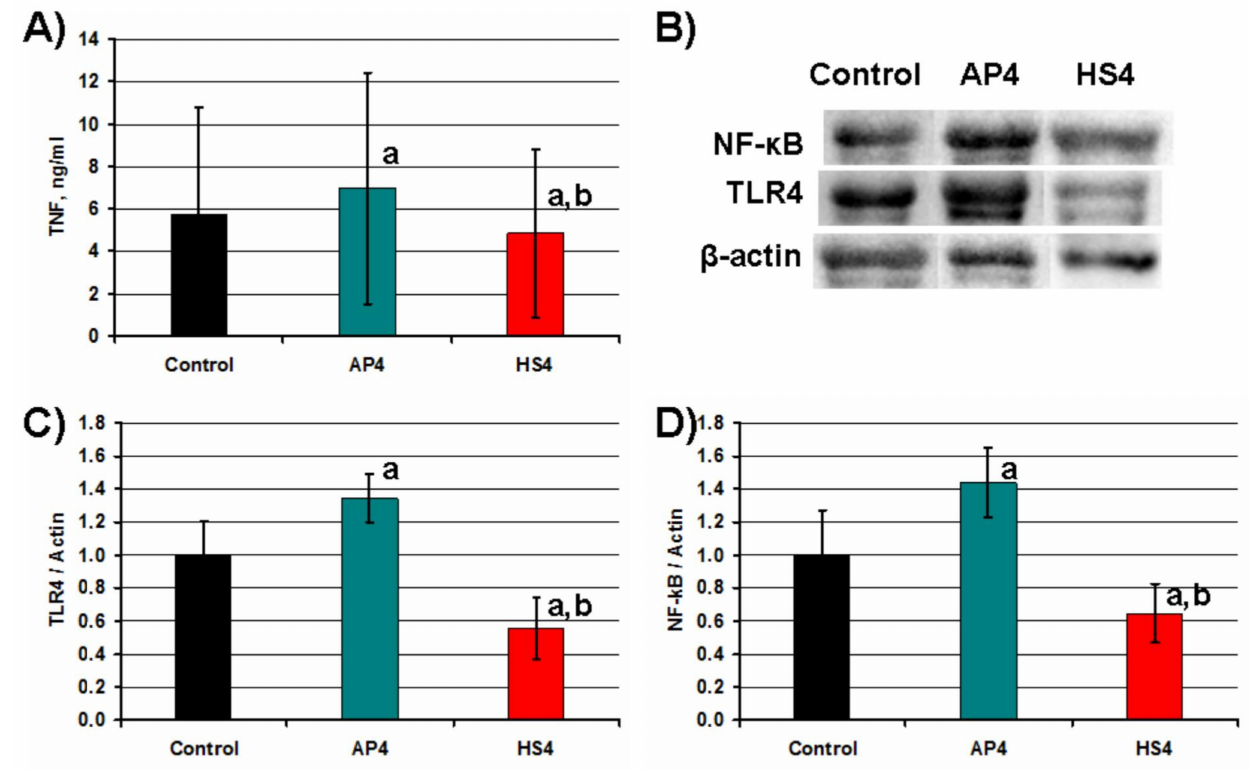
Figure 17. The impact of pectin gel beads on inflammatory proteins levels in mouse peritoneal macrophages. Bar graphs show TNF- α concentration ( A ) and TLR4 ( C ), and NF- κ B ( D ) protein levels, which are normalized to the β -actin protein level. ( B )—representative bands of NF- κ B, TLR4, and β -actin. The results are expressed as the mean ± S.D. (n = 8). a and b — p < 0.05 vs. Control and AP4 gel beads, respectively.